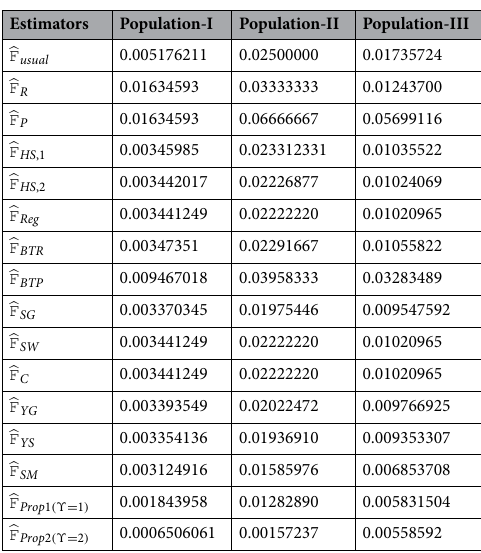
Table 2. Mean square error using real data sets.